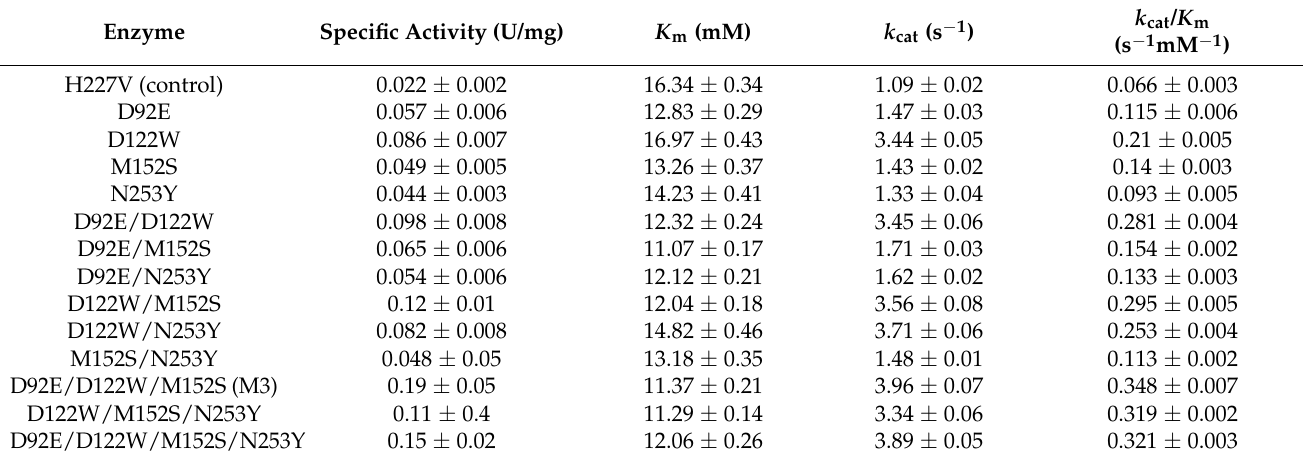
Table 1. Specific activities of StDAPDH/H227V and the mutants toward hydroxypyruvate. Enzyme